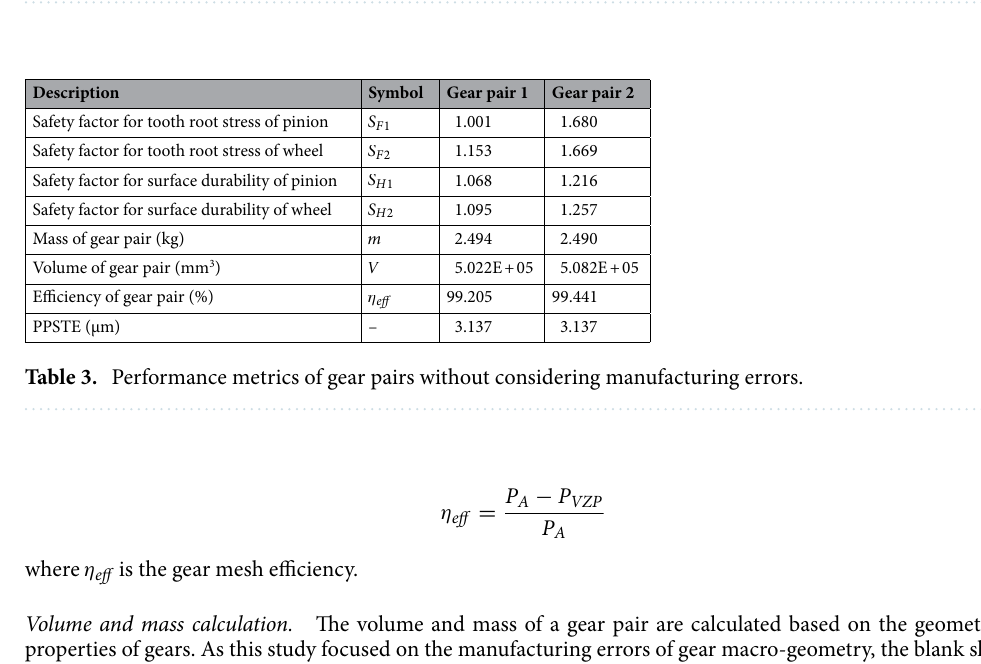
Table 2. Macro-geometry of gear pairs.